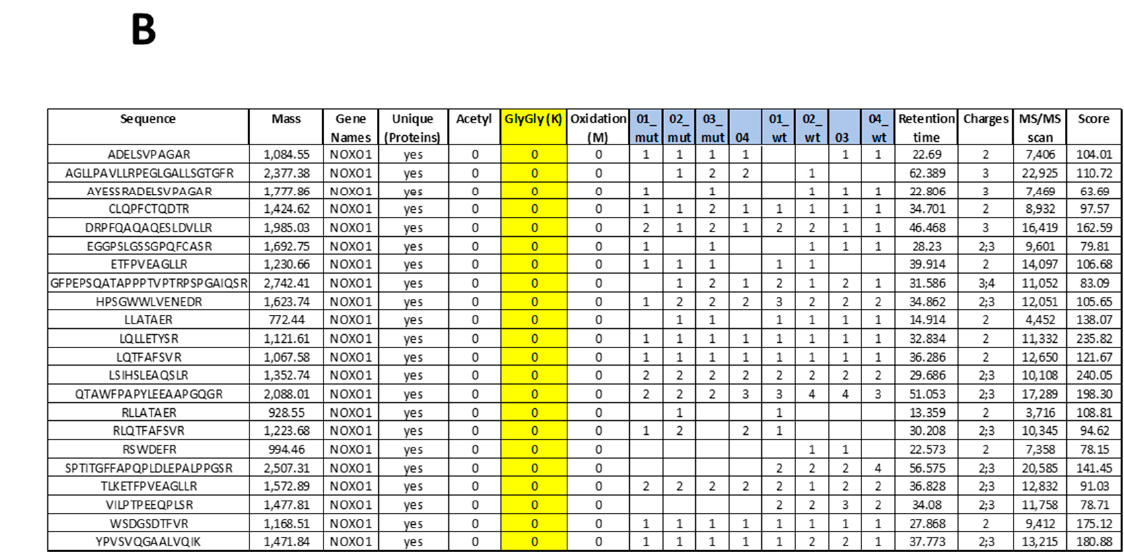
Figure A4. Noxo1-DDK stability analysis using proteasomal inhibitor MG132 in Caco-2 cells over- expressing wt or mut1 Noxo1-DDK. ( A ) Caco-2 cells were treated with MG132 (for 1 or 4 h, 5µM). Immunoblot of vinculin, Noxo1-DDK, and cyclin d1. Vinculin was used as the loading control, and cyclin d1 was used as the positive control for proteasomal degradation. ( B ) Identification of possible ubiquitination by immunoprecipitation of overexpressed wt Noxo1-DDK or mut1 Noxo1-DDK by anti-DDK antibody followed by MassSpec analysis on 8 biological replicated experiments (4 wt and 4 mut) researched with Maxquant software with ubiquitination(glygly) as potential modification (yellow highlighted) developed on the PINT facility (https://inp.univ-amu.fr/en/facilities/pint, accessed on 15 February 2023).